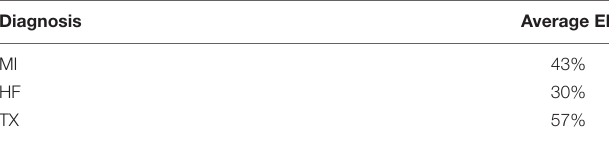
TABLE 7 | Average EF values for each subgroup of